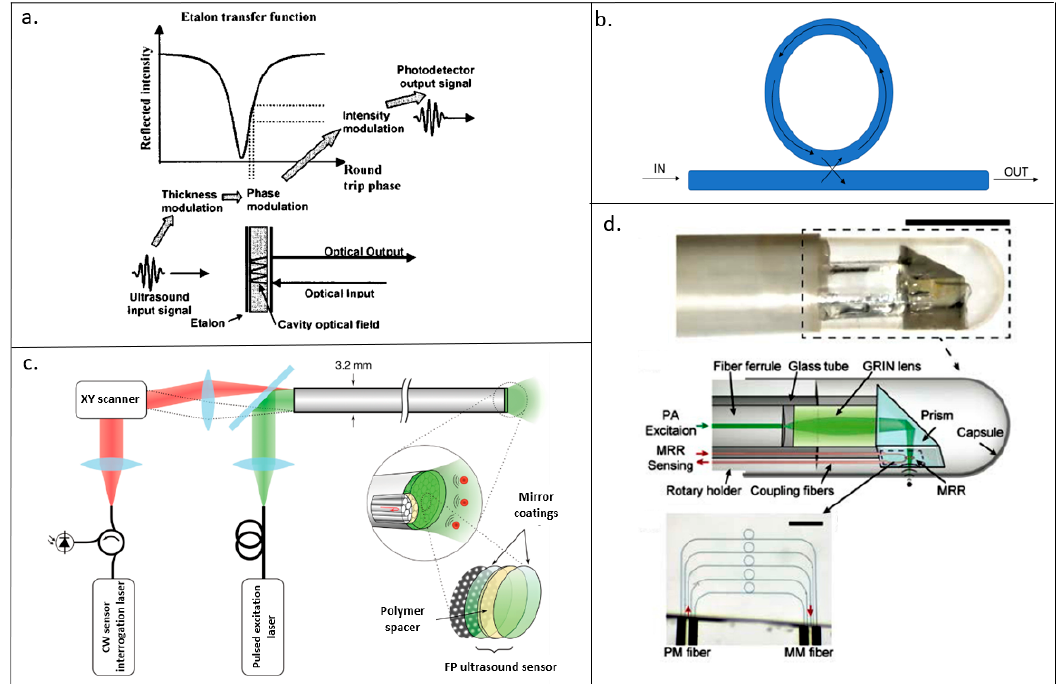
Figure 1. ( a ) Diagram of the working principle of Fabry–Perot interferometers (FPI). An incoming ultrasound wave causes a variation in thickness which in turn results in a phase modulation (Reproduced from [88], with the permission of AIP Publishing.); ( b ) schematic diagram of an micro ring resonators (MRR); ( c ) schematic diagram of a forward-viewing photoacoustic probe for endoscopy imaging used in [69]; ( d ) photoacoustic endoscopy with a MRR detector used in (Adapted with permission from ref [82], [The Optical Society]).